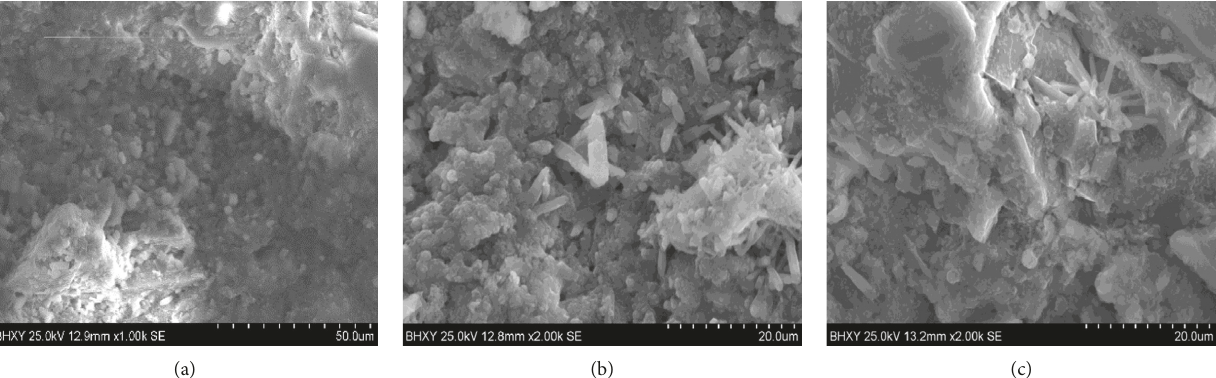
Figure 7: SEM images of different interfacial transition zones after carbonization: (a) LG-LJ interface; (b) LG-XJ interface; (c) LJ-XJ interface.